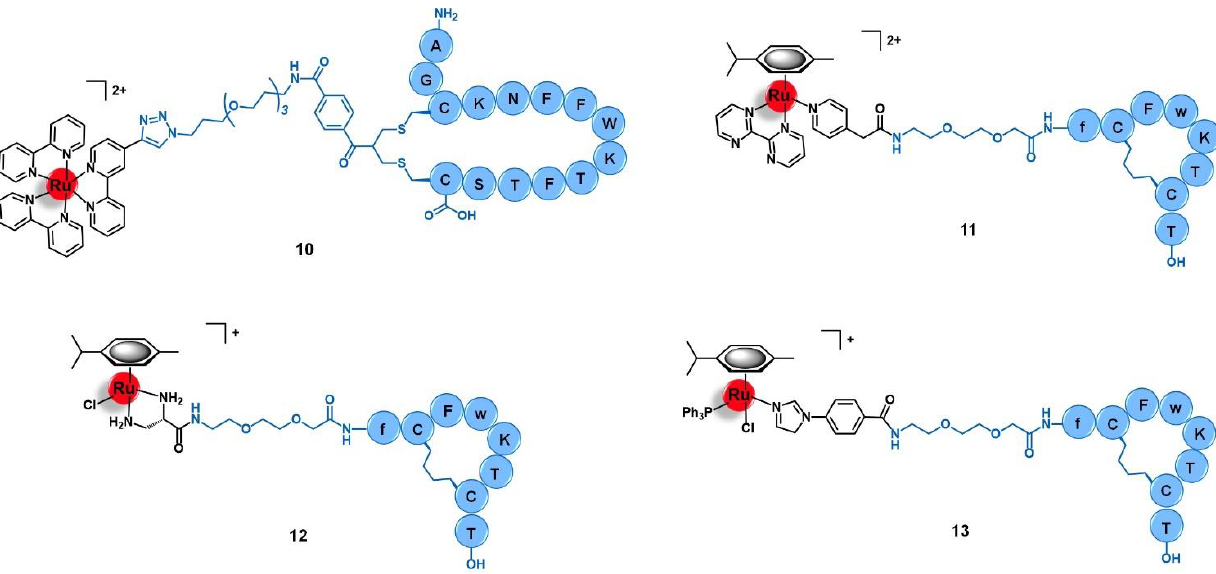
Figure 5. Ru(II) conjugates that target the somatostatin receptors (SSTR) have as vectors peptides derived from somatostatin ( 10 ) or octreotide ( 11 to 13 ). Note: f = D-phenylalanine; w = D-tryptophane.